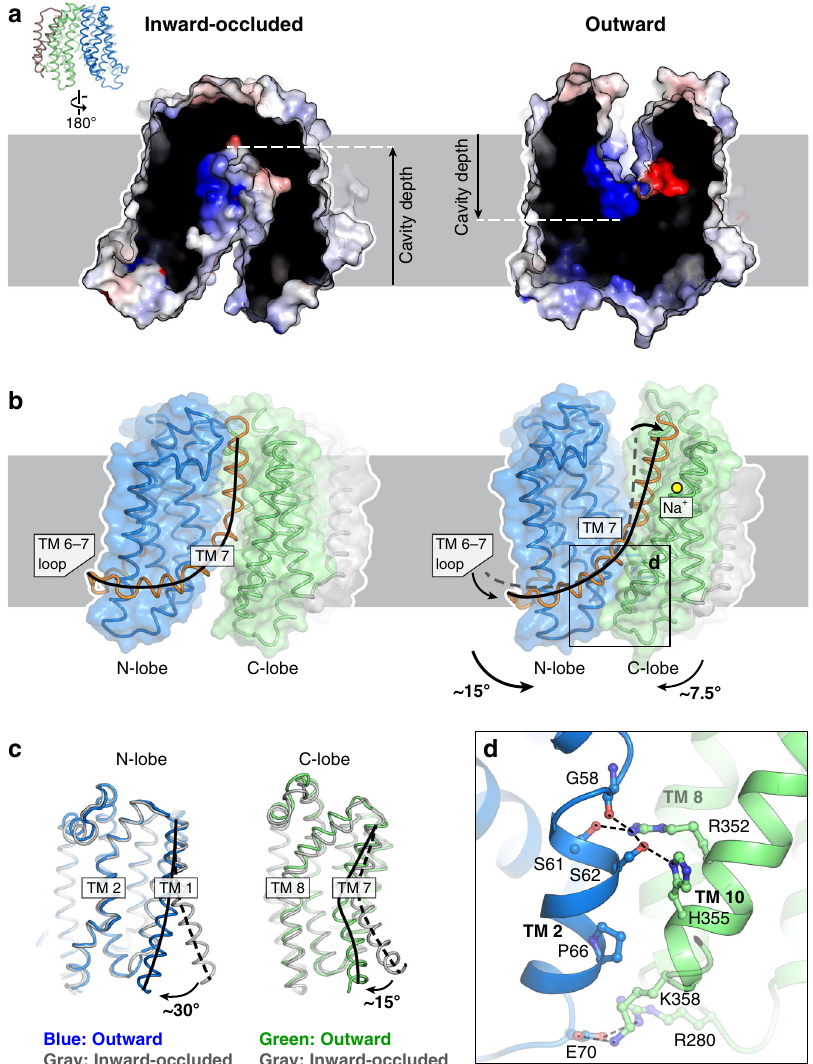
Fig. 4 The outward conformation of MurJ TA . a The outward-facing cavity is more shallow and narrow than the inward-facing cavity. b Straightening of TM 7 and concomitant lowering of the TM 6 – 7 loop could close the cytoplasmic gate, allowing transition from the inward-occluded to the outward-facing conformation. c Alignment of N-lobes and C-lobes from the inward-occluded conformation (gray) to those of the outward-facing conformation (in color), showing rotation of not just TM 7 but also TM 1, the latter closing the lateral membrane portal. d The cytoplasmic gate is mainly stabilized by a hydrogen bond network between TMs 2 and 10, with less-conserved electrostatic interactions at the cytoplasmic